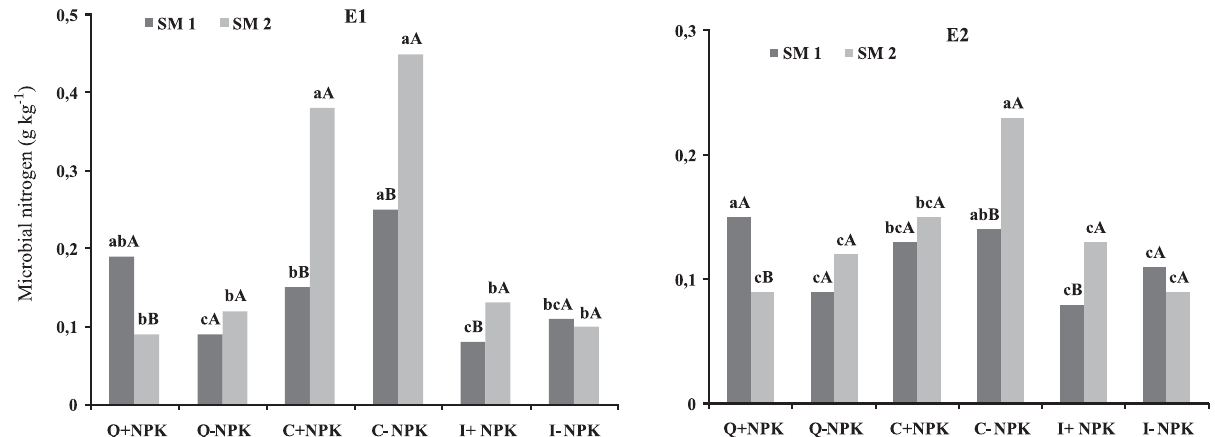
Figure 2. Microbial nitrogen in a Yellow Latosol, in the 0–0.1 m layer, under management systems in two seasons, rainy (S1) and dry (S2), S1, CV (%) = 6.9; S2, CV (%) = 29.8.